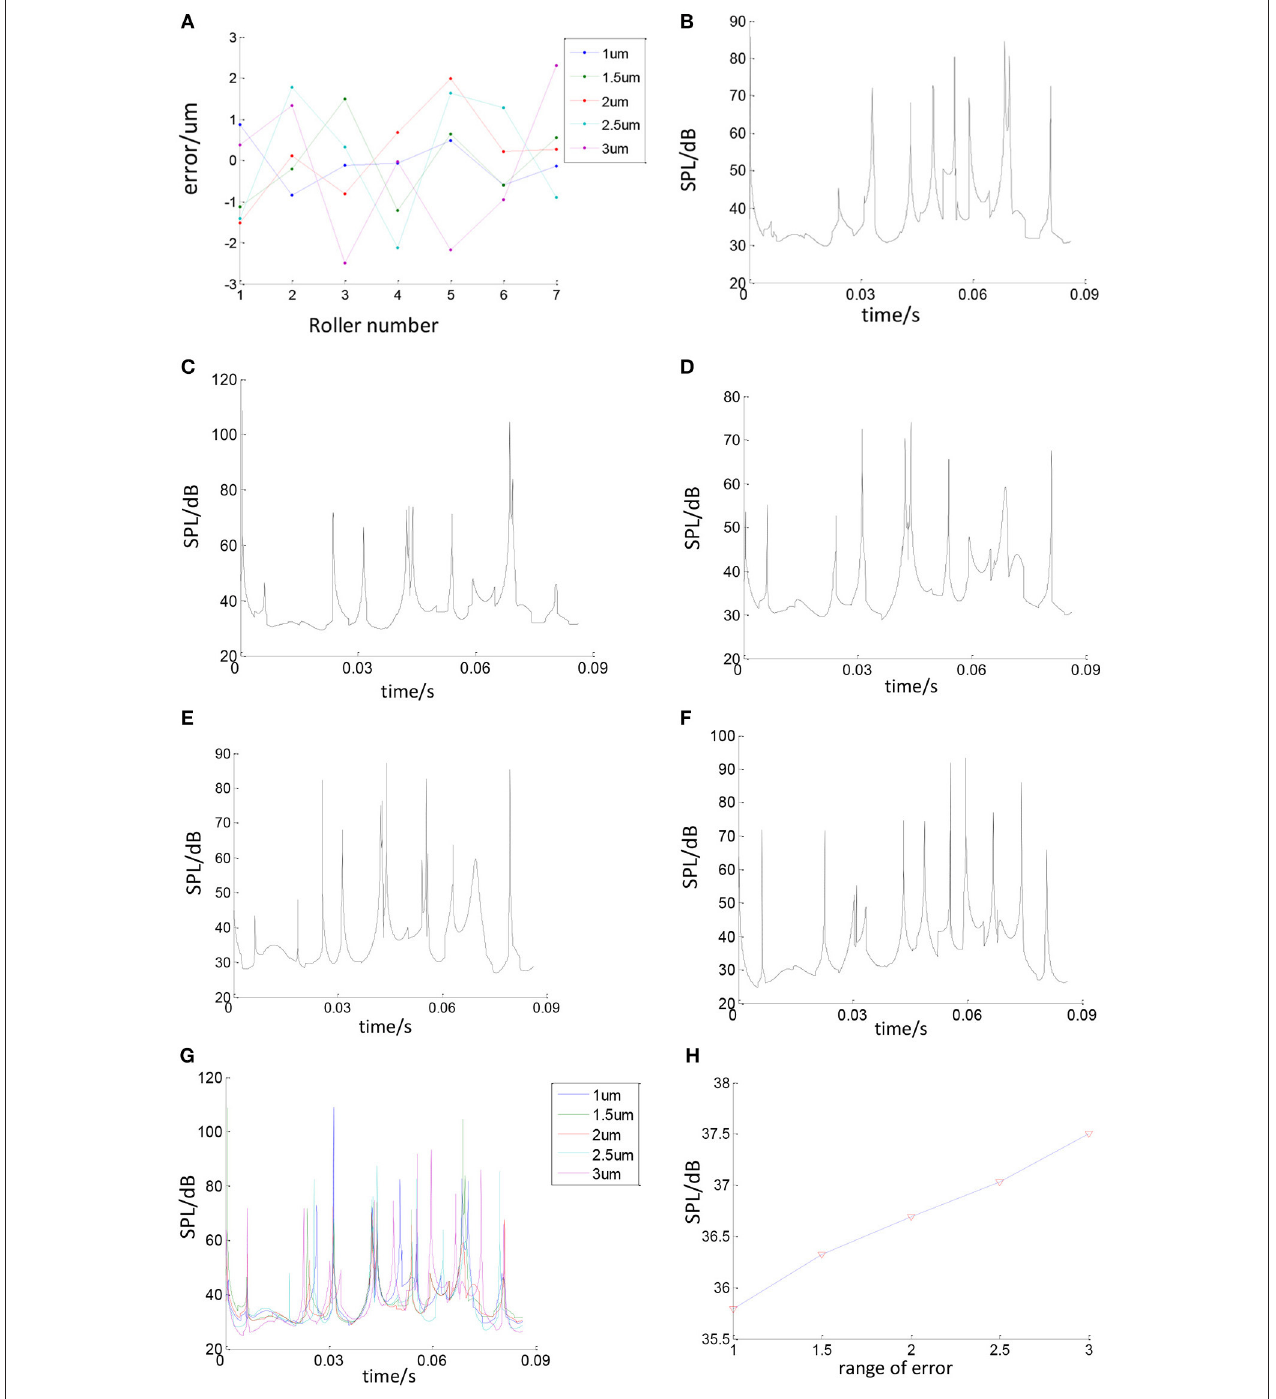
FIGURE 20 | The relationship between ball errors and bearing SPL. (A) Ball errors distribution. (B) Roller error range is 1 um. (C) Ball size error band is 1.5 um. (D) Ball size error band is 2 um. (E) Ball size error band is 2.5 um. (F) Ball size error band is 3 um. (G) Effect of ball errors on bearing SPL. (H) Effect of ball errors on average bearing